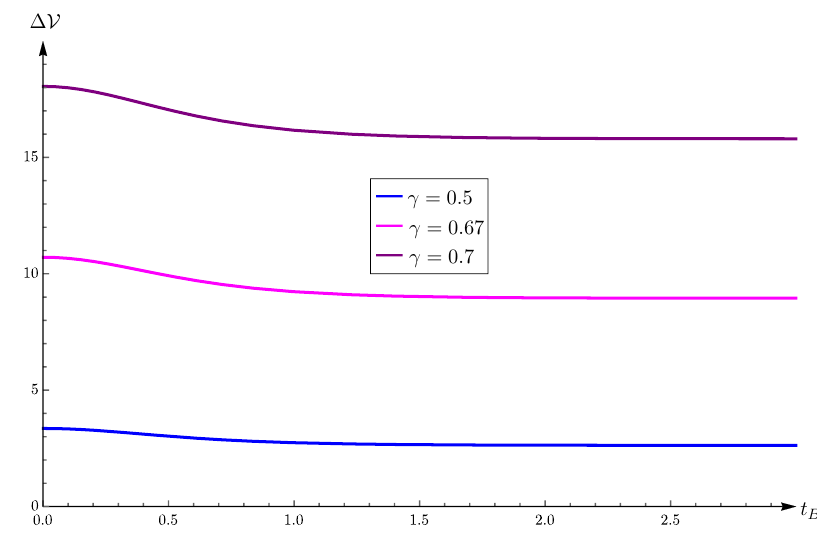
Figure 13 . Plot of the quantity ∆ V ( t B ) defined in eq. (5.35) for various values of γ . When γ = 0 , this function is vanishing by